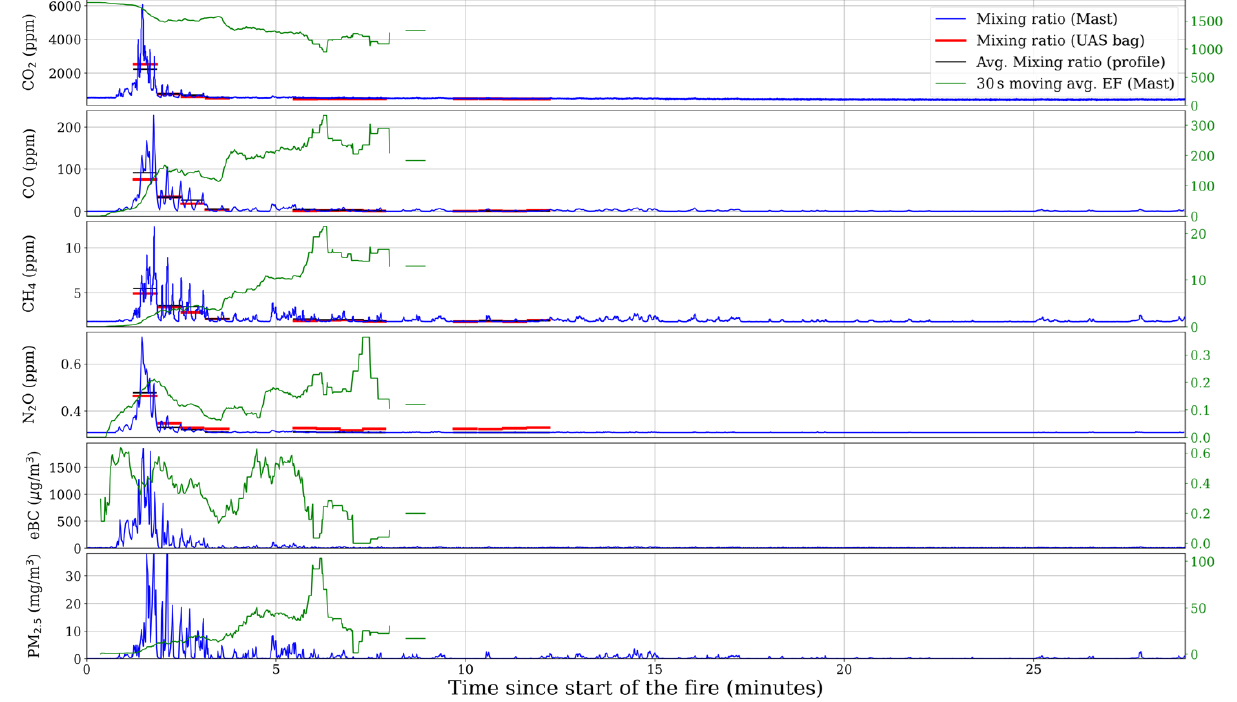
Figure 2. Example of a mast measurement profile (blue, left y axis represents the absolute concentration) for a prescribed burn near Skukuza at the KNP in August and the corresponding emission factors (green, right y axis). The red stripes represent the timing and measurement of the UAS sampled bags. The UAS was positioned close to the measurement inlet on the mast.